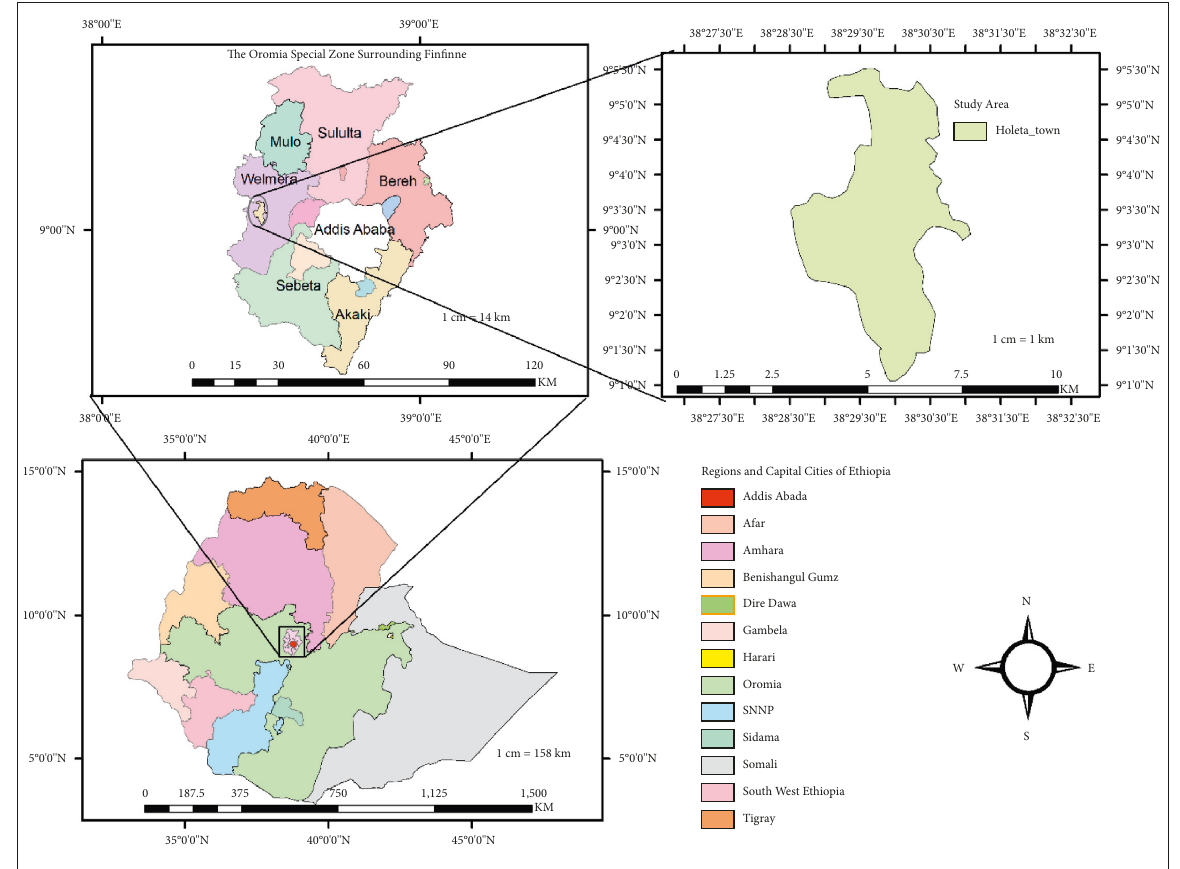
Figure 1: Map of Holeta